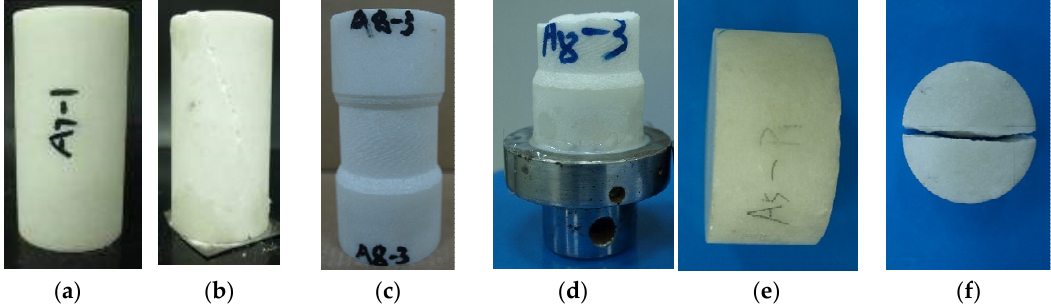
Figure 1. Typical photographs of rocks before and after testing under different loading modes [22] Reproduced from [22], Sichuan University: 2010. ( a ) Before the uniaxial compression test (UCT), ( b ) After the UCT, ( c ) Before the direct tensile test (DTT), ( d ) After the DTT, ( e ) Before the indirect tensile test (ITT), ( f ) After the ITT.